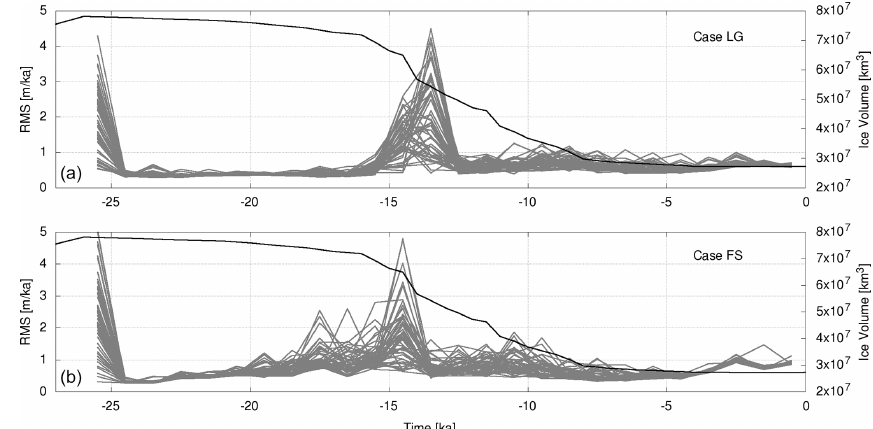
Figure 14. Measures of misfit variation in the ensemble of two regional observation sets, namely North America and Greenland (a) and Fennoscandia (b) . Shown are the RMS values of the difference between the observations and the model predictions. The black lines show the total ice volume according to the external ice model. There are spikes following large changes in total ice mass that can be explained by the different response times of the reference model and the ensemble member to a changing mass load. The response time depends on the mantle viscosity of the individual model.